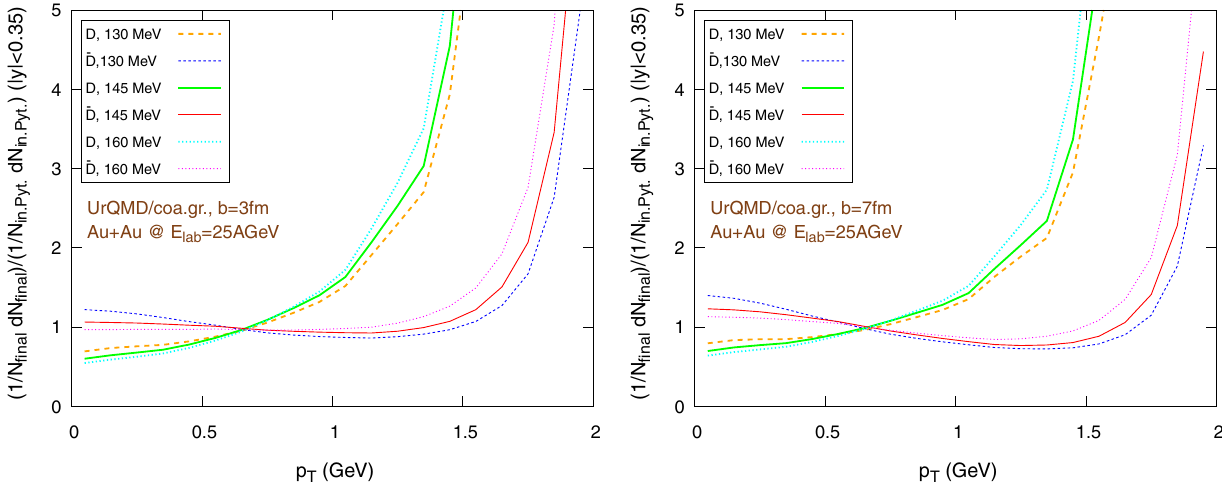
Fig. 15 ˜ R AA , i.e. the ratio of the individually normalized distributions 1 / N final d N final / d p T in Au+Au collisions and 1 / N in. Pyt. d N in. Pyt. / d p T inppcollisions(simulatedwithPythia),intherapidityrange | y | < 0 . 35,